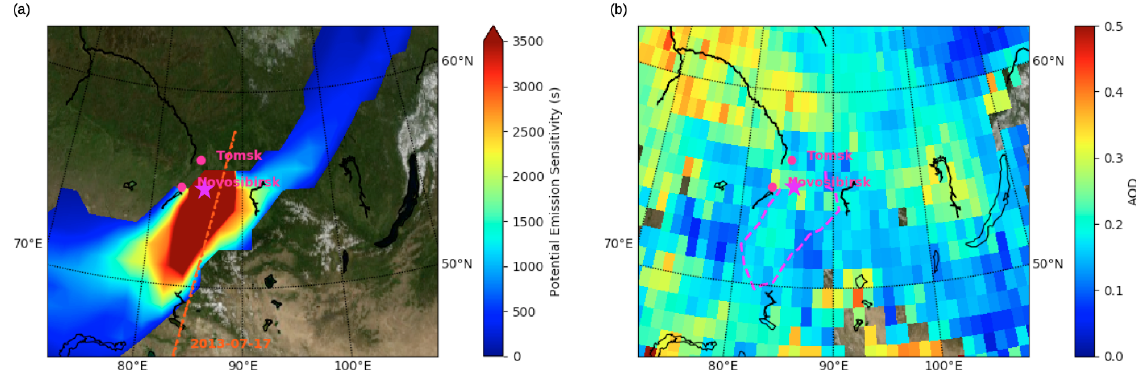
Figure 19. ( a ) as Figure 4a for the aerosol layer of Figure 18. Orange dotted line is the position of CALIOP overpass on 17 July 2013 at 20 UT. ( b ) as Figure 4b with averaging of MODIS AOD 550 from 17 to 20 July